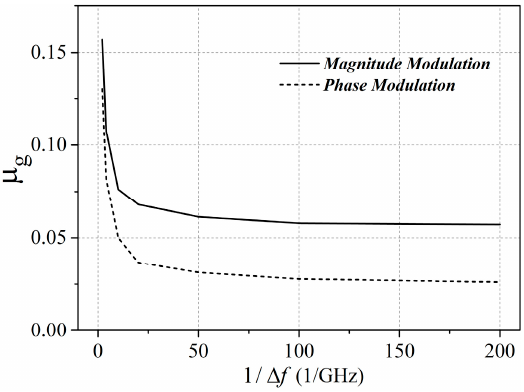
Figure 3. Comparison of the average mutual coherence μ g between phase and amplitude modulation.